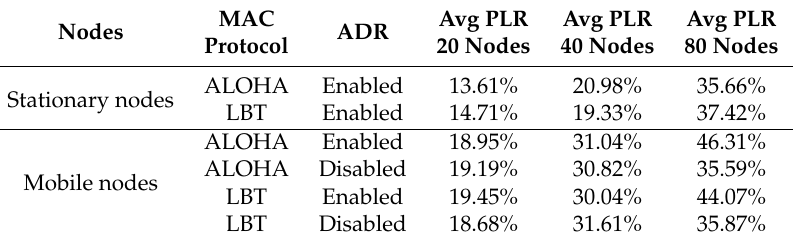
Table 4. Average PLR - Confirmed